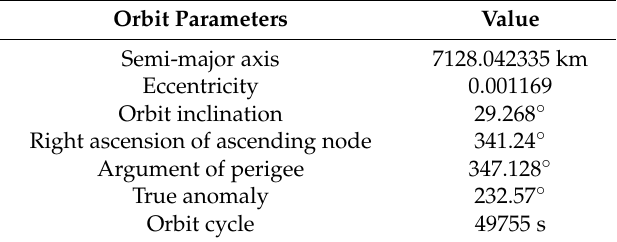
Table 1. The parameters of the spacecraft.